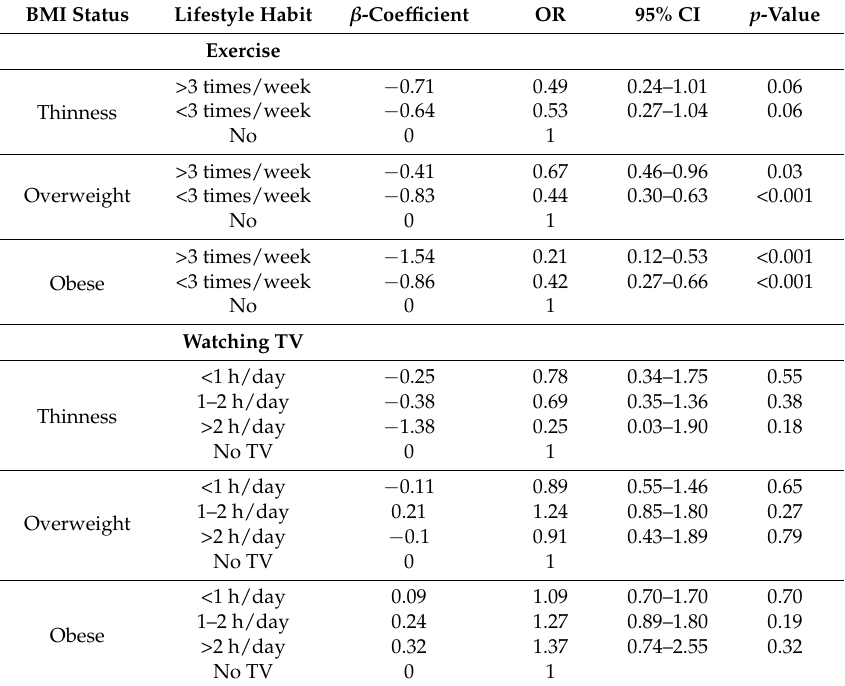
Table 4. Potential risks of lifestyle habits on thinness, overweight, and obesity of adolescent male students